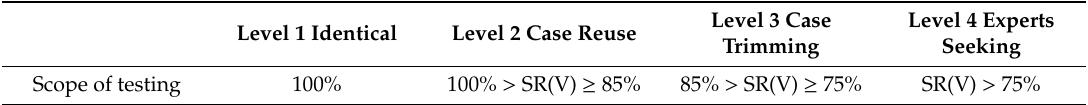
Table 6. Similarity value threshold.